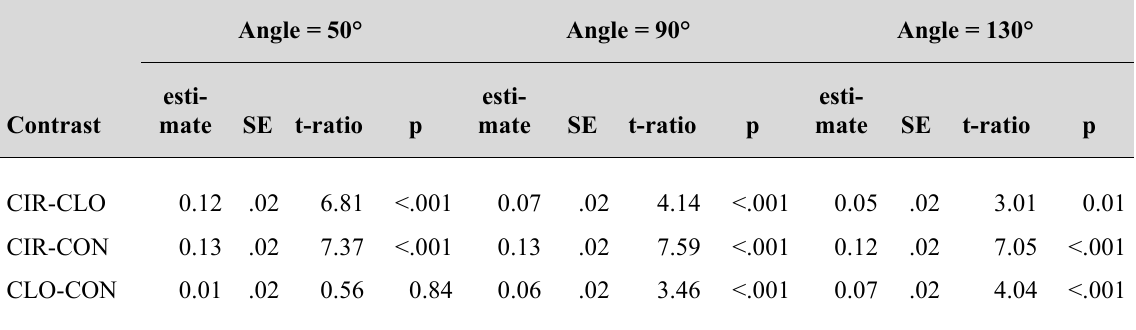
esti- mate SE t-ratio p